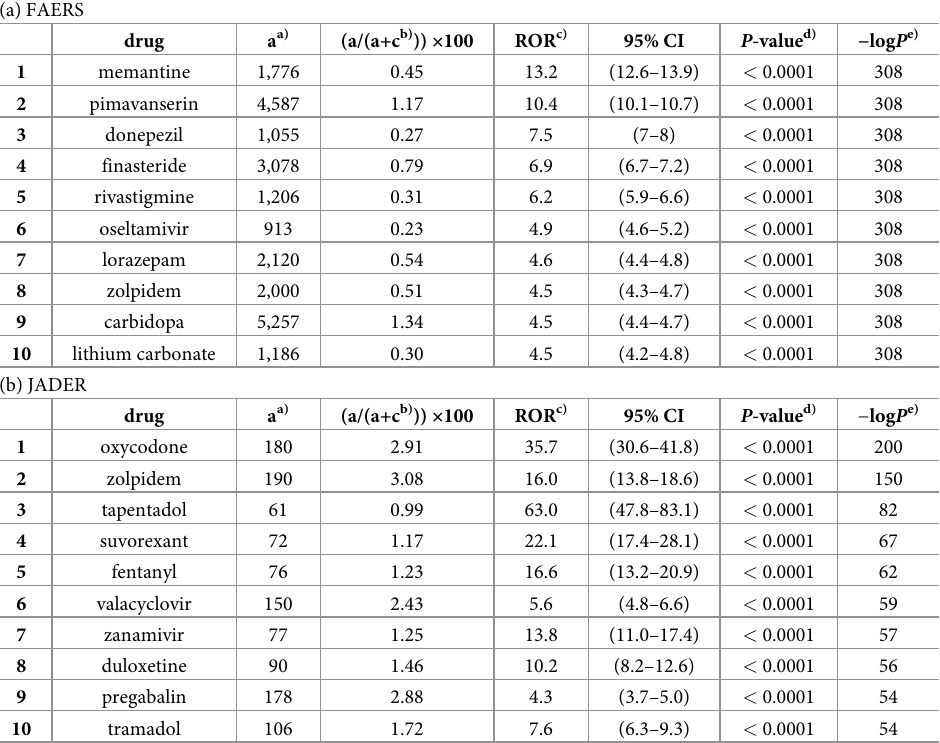
Table 3. Major suspected drugs of CNS. (a) FAERS (b)